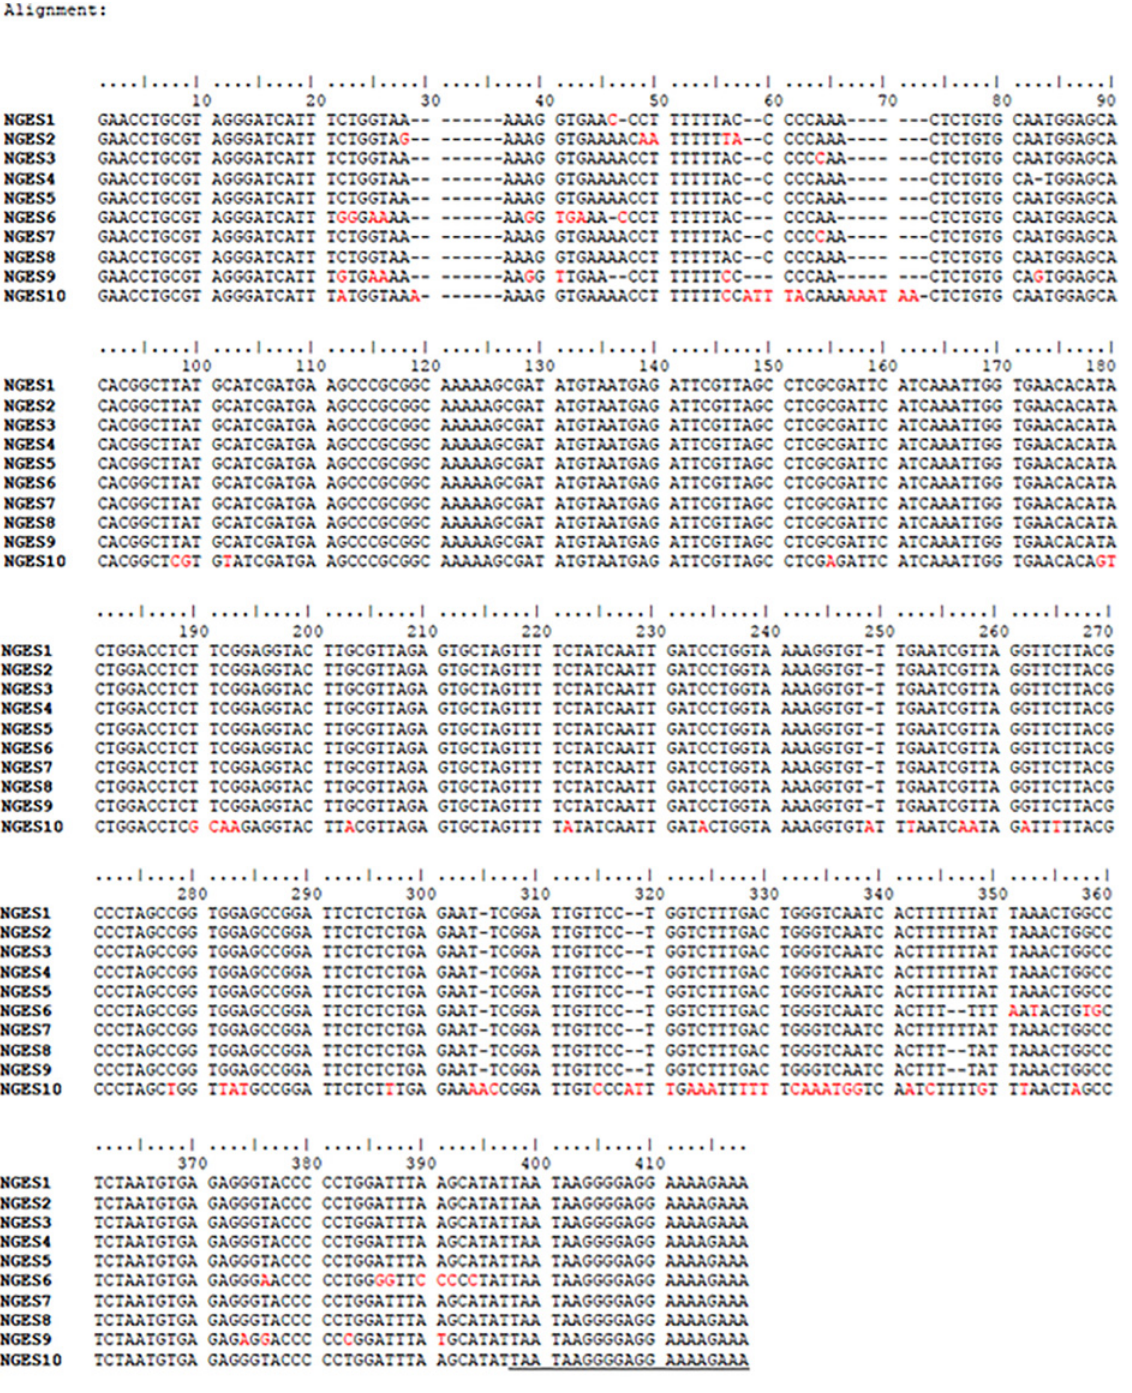
Fig 3. Multiple sequence alignment for amplicons NGES1-NGES10 using ClustalW program. Black colour dash ( — -) indicates gap, red colour fonts base substitution or base insertion, forward and reverse primers are